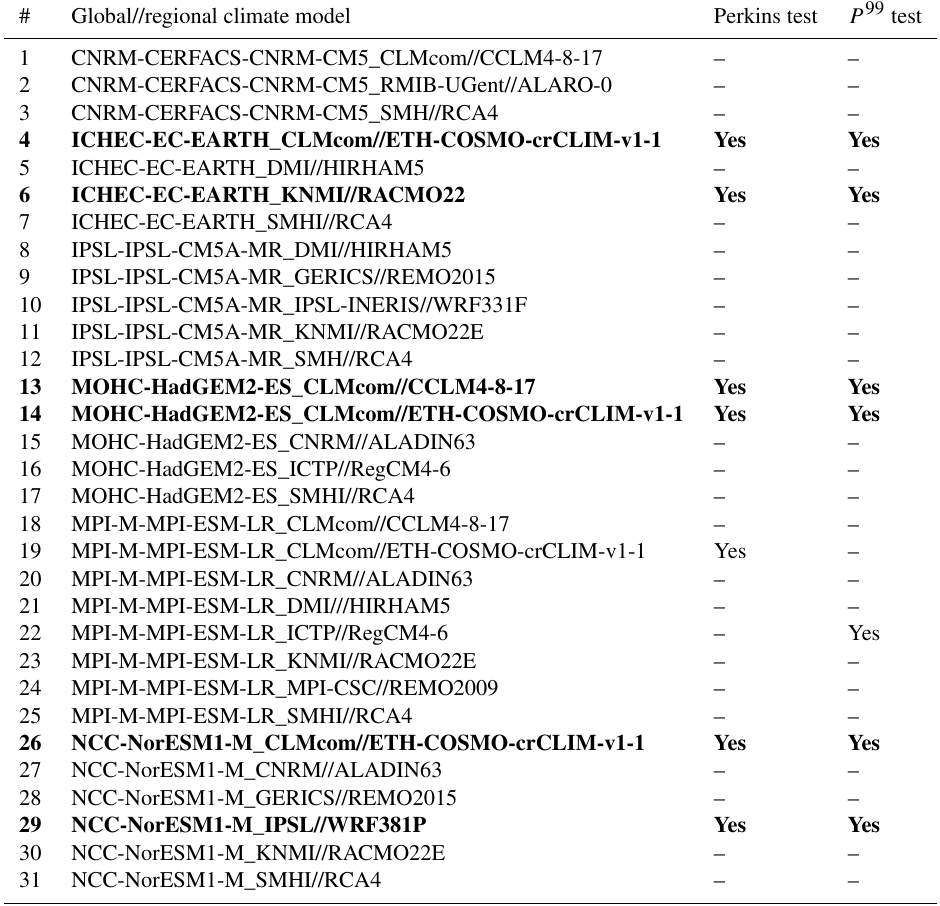
Table 2. Regional climate models (RCMs) driven by global climate models (GCMs) from the EURO-CORDEX project. The Perkins test indicates those models with skills above 90% to reproduce measured values over the wet season (NDJFM). Twenty bins were considered in the Perkins analysis. The P 99 test indicates those models with a deviation of below 25% when extreme values (above the 99th percentile) were compared with measured data over the wet season. Models fulfilling both conditions are highlighted in